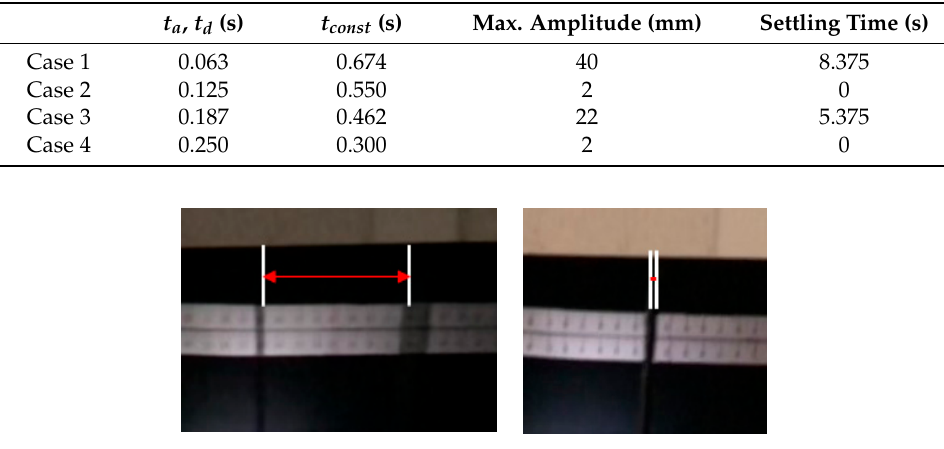
Figure 12. The velocity profiles when moving 500 mm over 0.8 s. Table 2. Experimental results of maximum amplitude and settling time when moving 500 mm over 0.8 s.